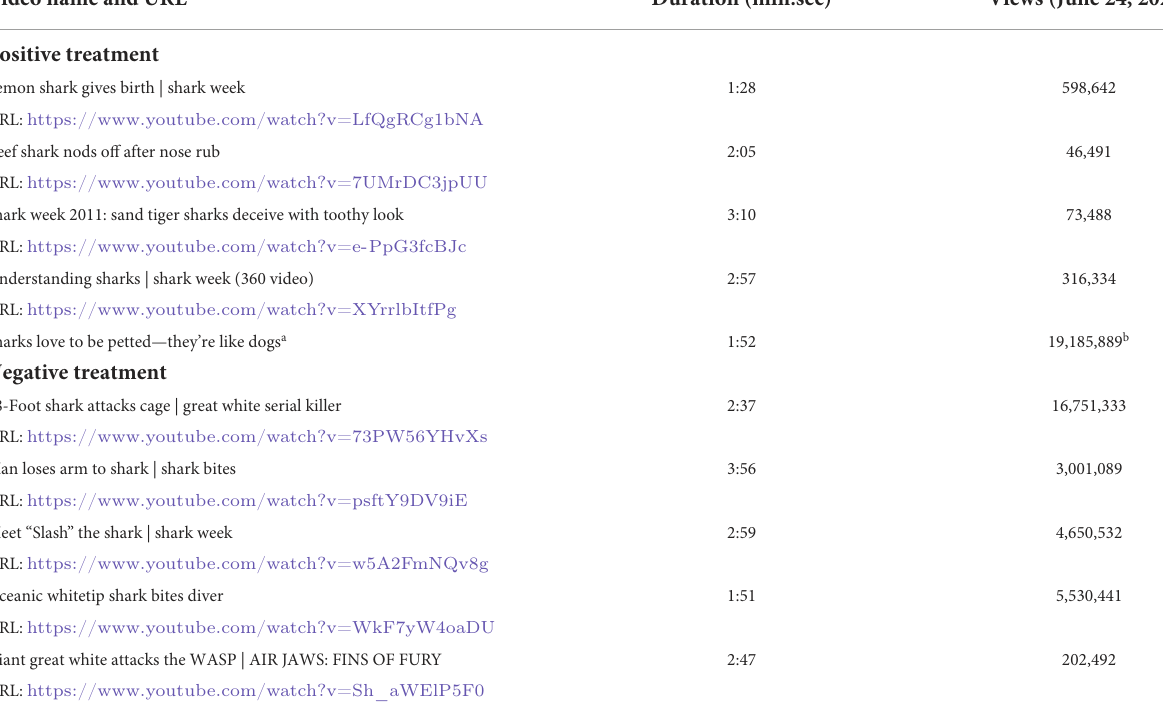
TABLE 1 Video names, URLs, duration, and view counts for videos included in the positive and negative